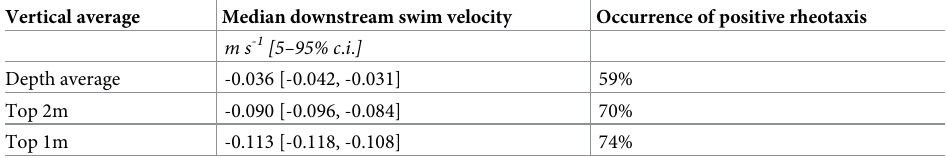
Table 2. Summary statistics of longitudinal swimming.